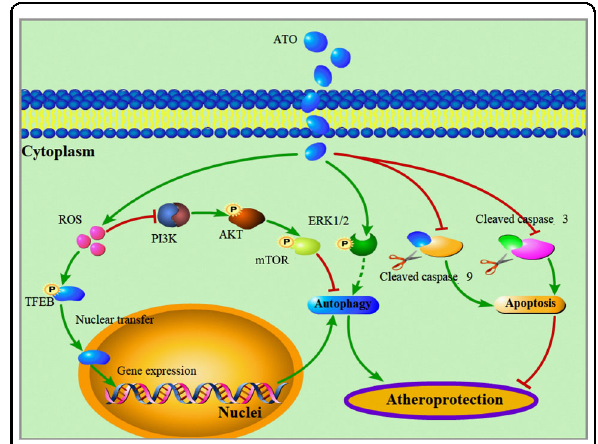
Fig. 8 Proposed model describing the mechanism of autophagy activation and atheroprotection by ATO. The green arrows represent promotion. The red arrows with fl at end represent